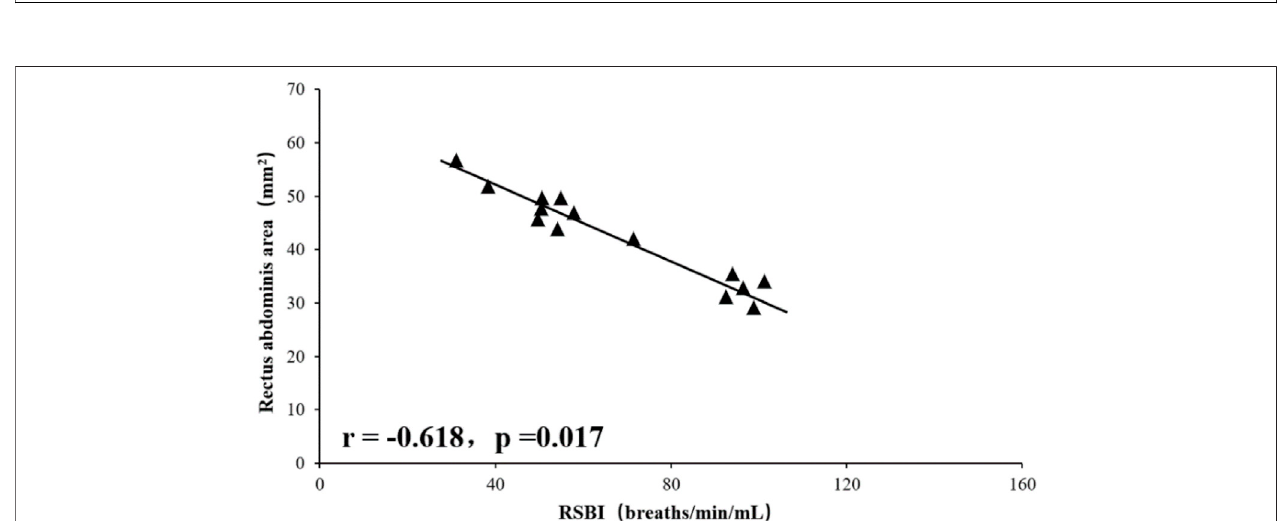
FIGURE 1 | Relationship between tidal volume and rectus abdominis area.